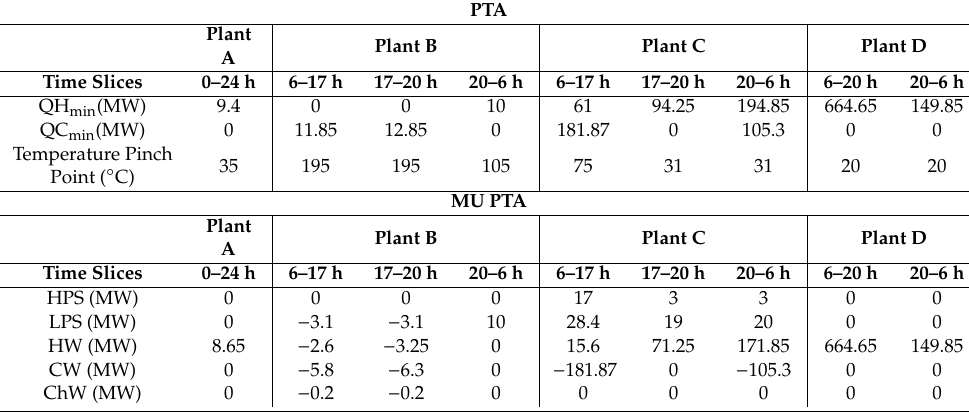
Table 7. Summary of the Problem Table Algorithm (PTA) and Multiple Utility PTA (MU